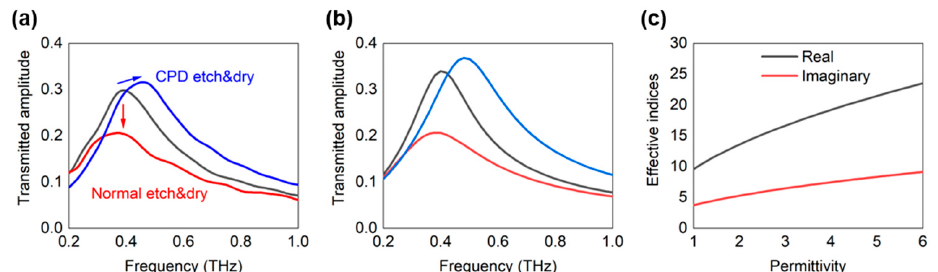
Figure 4. ( a ) Measured terahertz (THz) transmission spectra of 1.5-nm-wide nano-trenches before etching (black line), after wet etch and blow dry (red line), and after wet etch and CPD drying processes (blue line). Reduced transmission with no change in resonance frequency indicates damages in the gap, while increased transmission with a blueshift in the resonance shows successful removal of the dielectric between the two metallic layers. ( b ) Corresponding theoretical spectra calculated with coupled mode method. ( c ) Effective mode indices within a 1.5-nm-wide gap as a function of permittivity of the gap-filling material. The real (imaginary) part of the effective index induces frequency shift (amplitude change) of the resonance